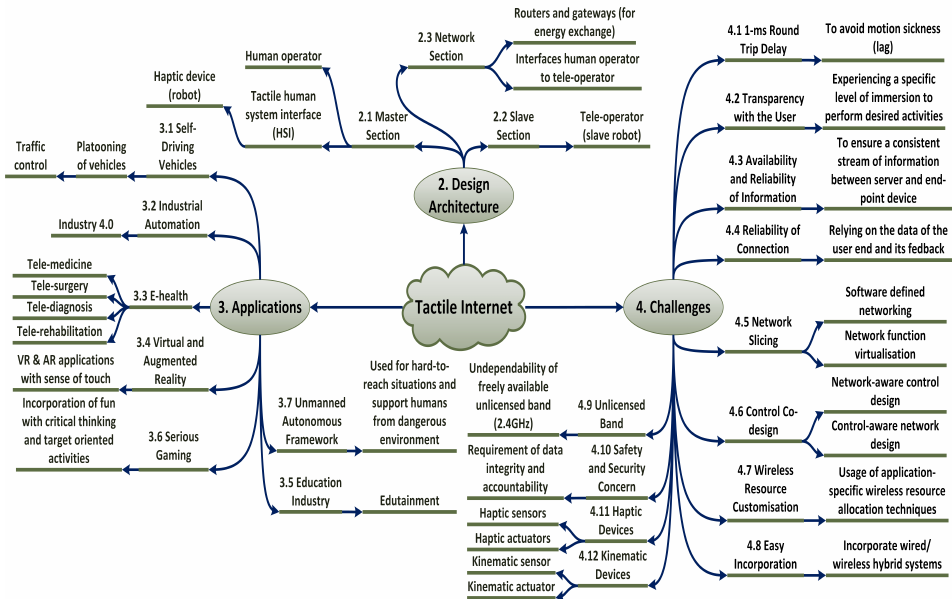
Figure 2. A mind-map of the topics related to the Tactile Internet (TI) discussed in this research.